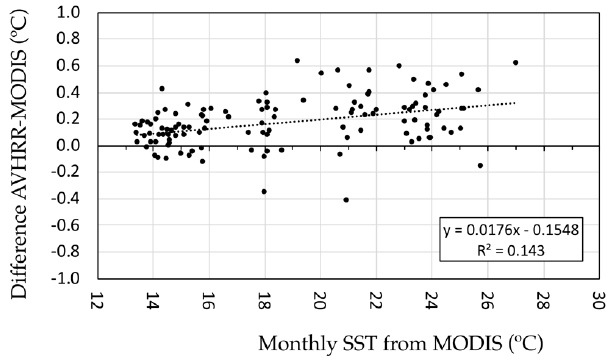
Figure 2. Monthly SST (left-hand scale) for 2000–2009 in the Western Mediterranean obtained from the Advanced Very High Resolution Radiometer (AVHRR) and MODIS data. The bars represent the monthly differences (right-hand scale) between the sensors.